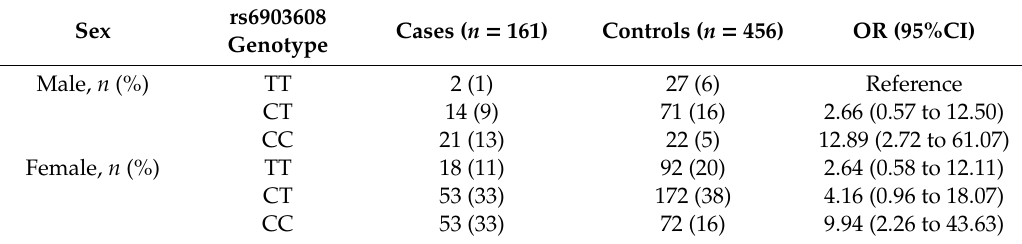
Table 3. Stratified analysis by sex.